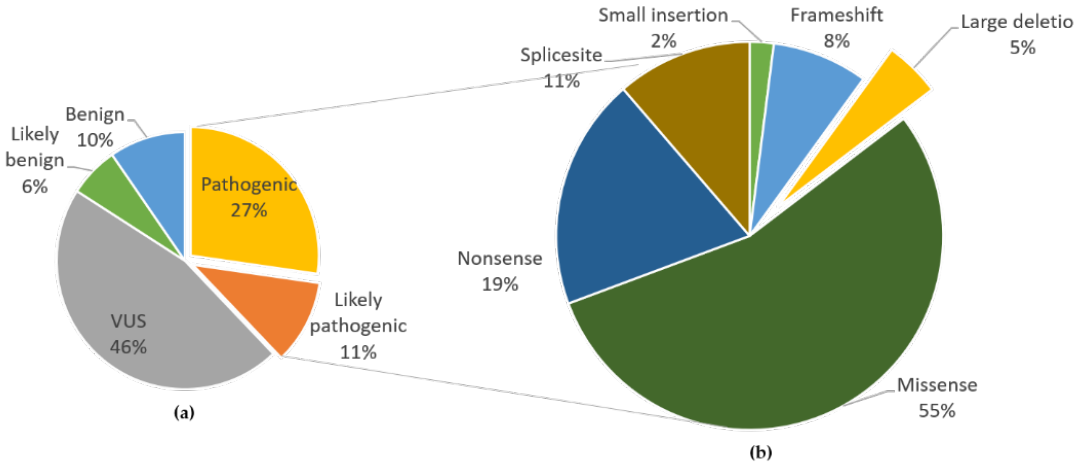
Figure 7. Summary of the relative frequency of FH variants. ( a ) Frequency of pathogenicity of 396 variants registered in the Leiden Open Variation Database (LOVD) [15]. Pathogenic variants comprised 27% and likely pathogenic variants 11% of all variants. ( b ) Types of pathogenic and likely pathogenic variants. Small deletions include all except whole-exon deletions, while large deletions include whole-exon to whole-gene deletions. VUS, variants of uncertain significance.